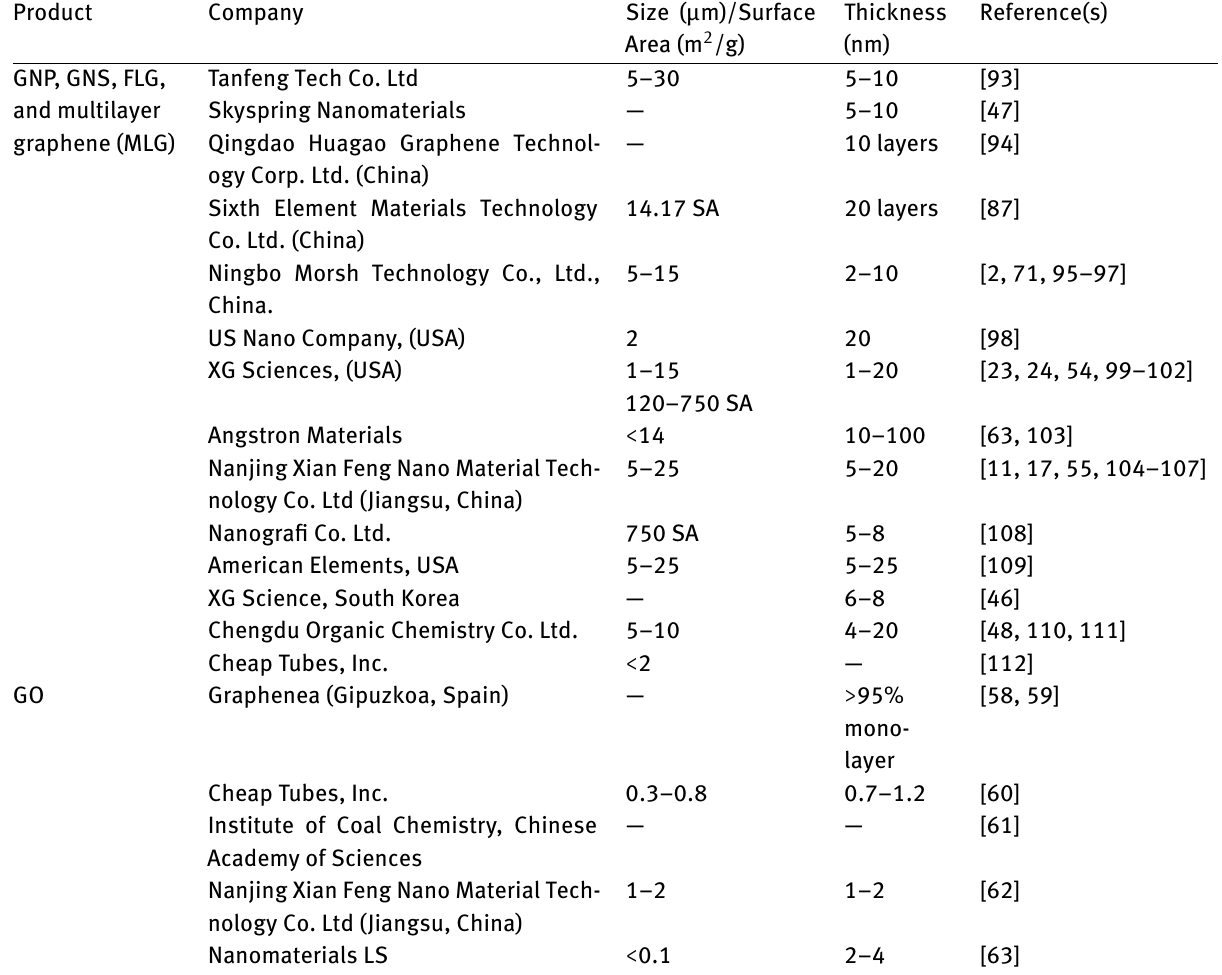
Table 1: Summary of Commercial Gr and its Derivatives Used in GRMMC Studies. Product